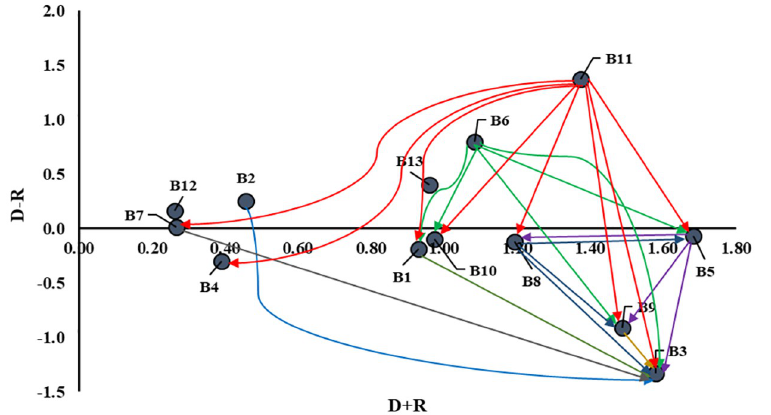
Fig 6. Relationships among the barriers.